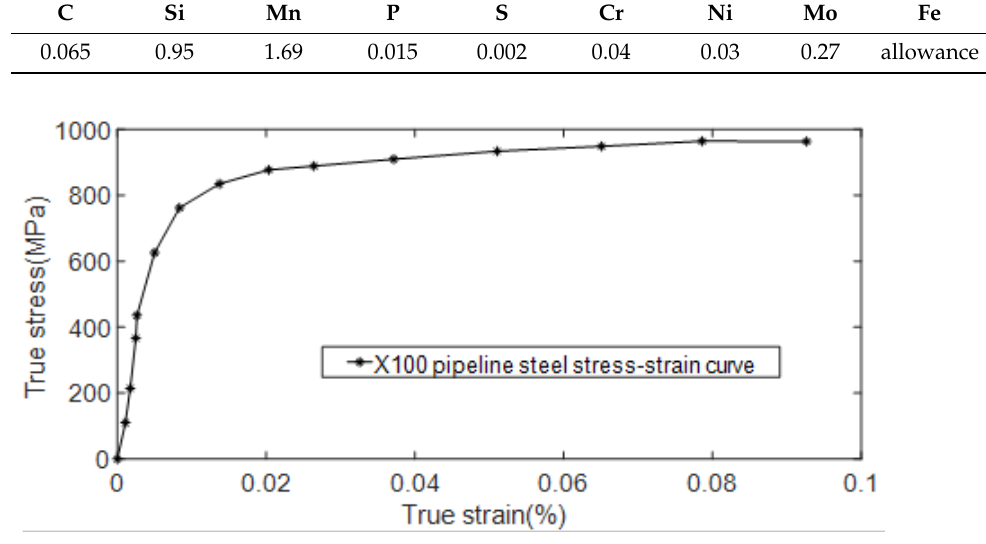
Figure 9. X100 pipeline steel true stress-strain curve.